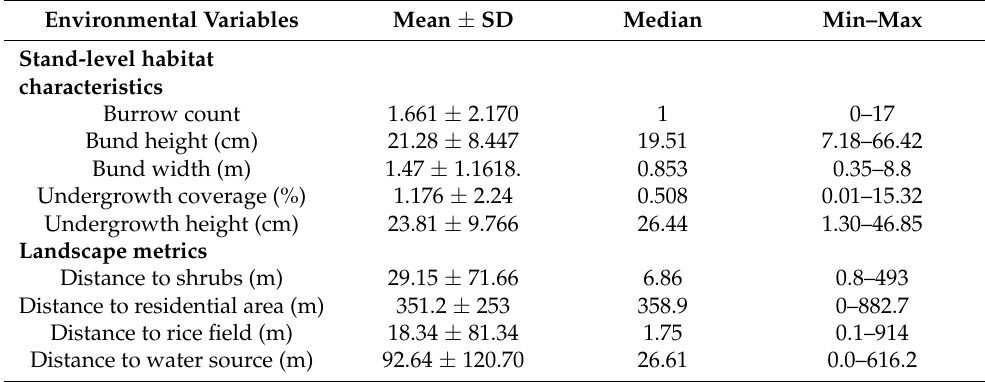
Table 2. Summary statistics for environmental variables.